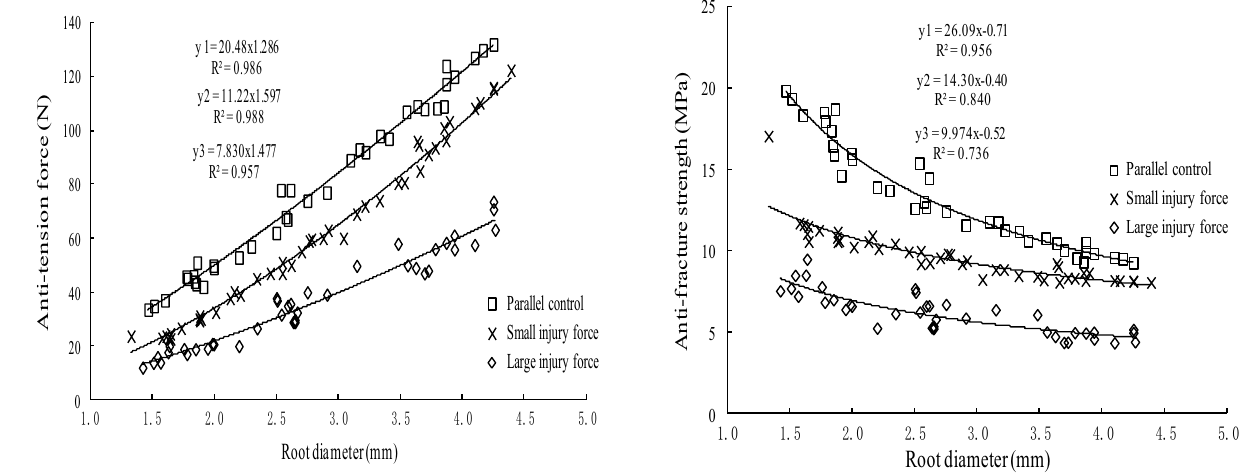
Figure 7. The differences in tensile ability between Hippophae rhamnoides L. roots after self-repair and parallel control roots. Tensile strength and induction rate after self-repair under different injury Plant species